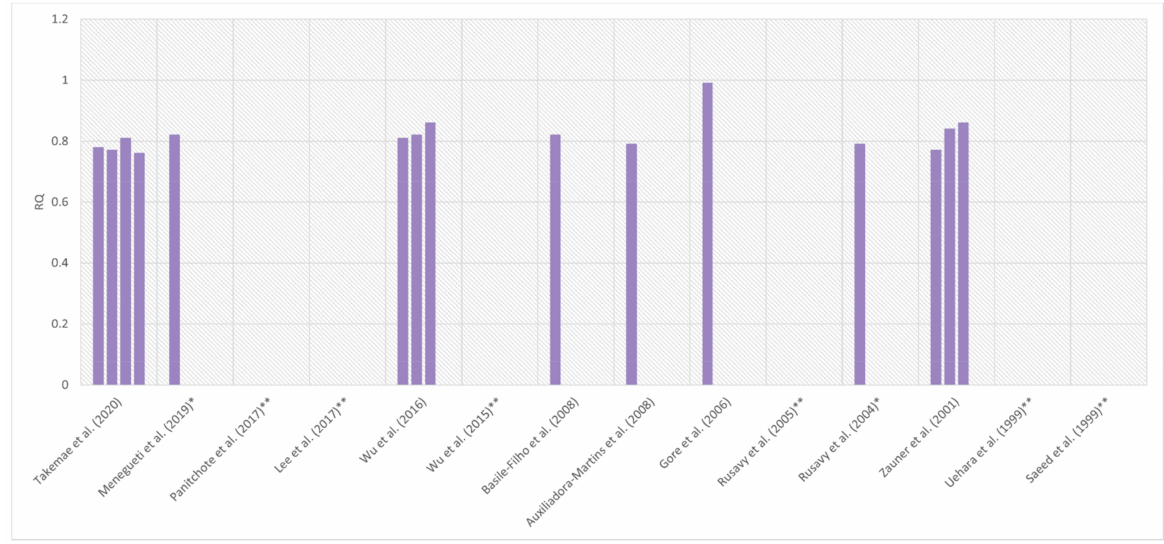
Figure 4. Comparison of mean respiratory quotient (RQ) measured by indirect calorimetry in patients with sepsis or septic shock in selected studies. [52–57,59–65,67] Some studies have reported more than one RQ value. Time and conditions for obtaining measurements in individual tests may be different. Table 2. * The value in the chart is the median RQ. ** The authors did not publish